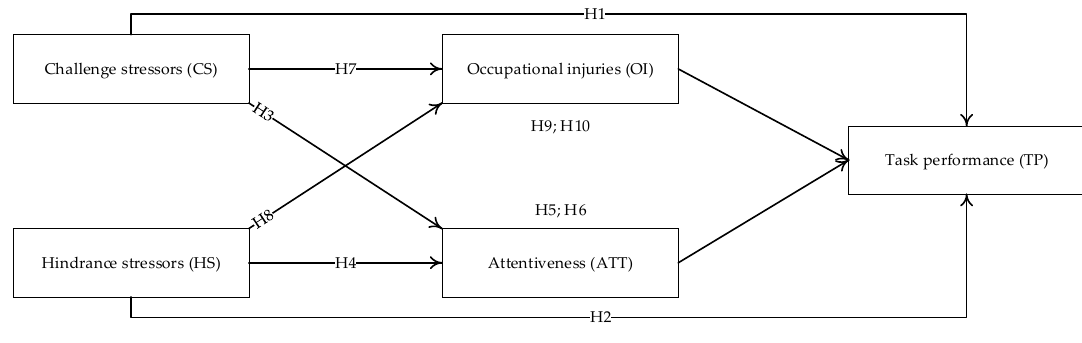
Figure 1. Conceptual model.